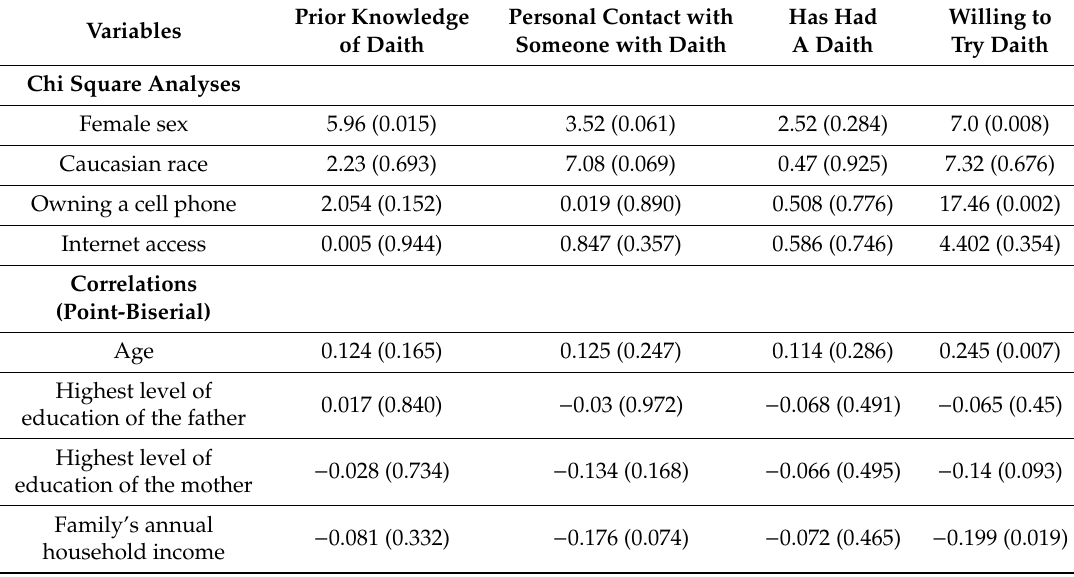
Table 2. Relationship of participant demographic variables with knowledge and experience of Daith piercing. p -values are reported in parentheses.